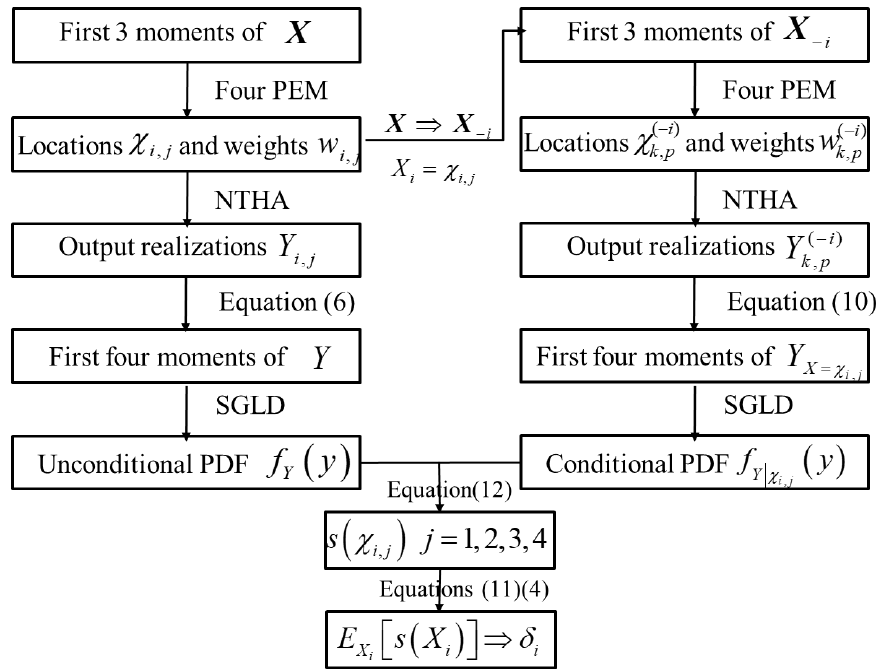
Figure 1. The flow chart of the proposed method.